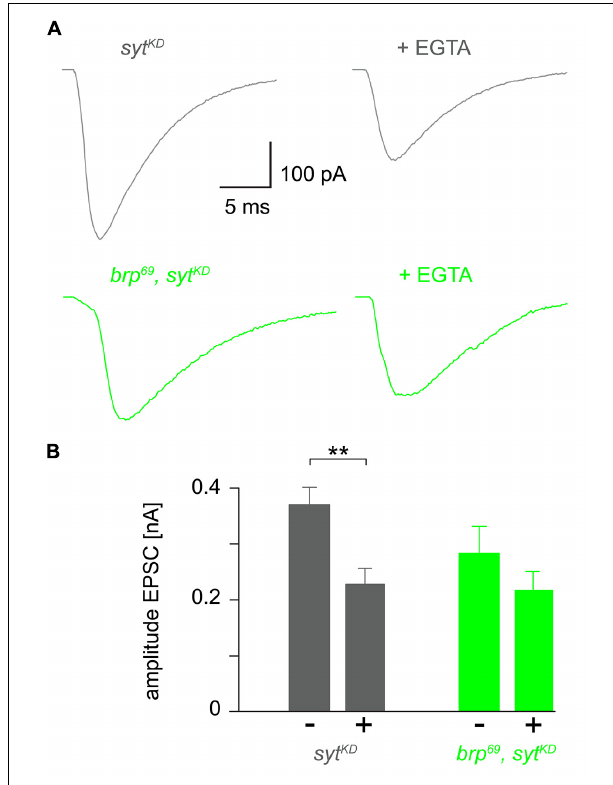
FIGURE 4 | Reduced EGTA sensitivity in brp 69 , syt KD . (A) Focally recorded, averaged EPSCs from syt KD (gray) and brp 69 , syt KD (light green) NMJs under control conditions and after incubation with 100 μ M EGTA-AM for 10 min ( + EGTA). (B) Summary bar graph of EPSC amplitudes without (–) or with ( + ) EGTA-AM in both genotypes.